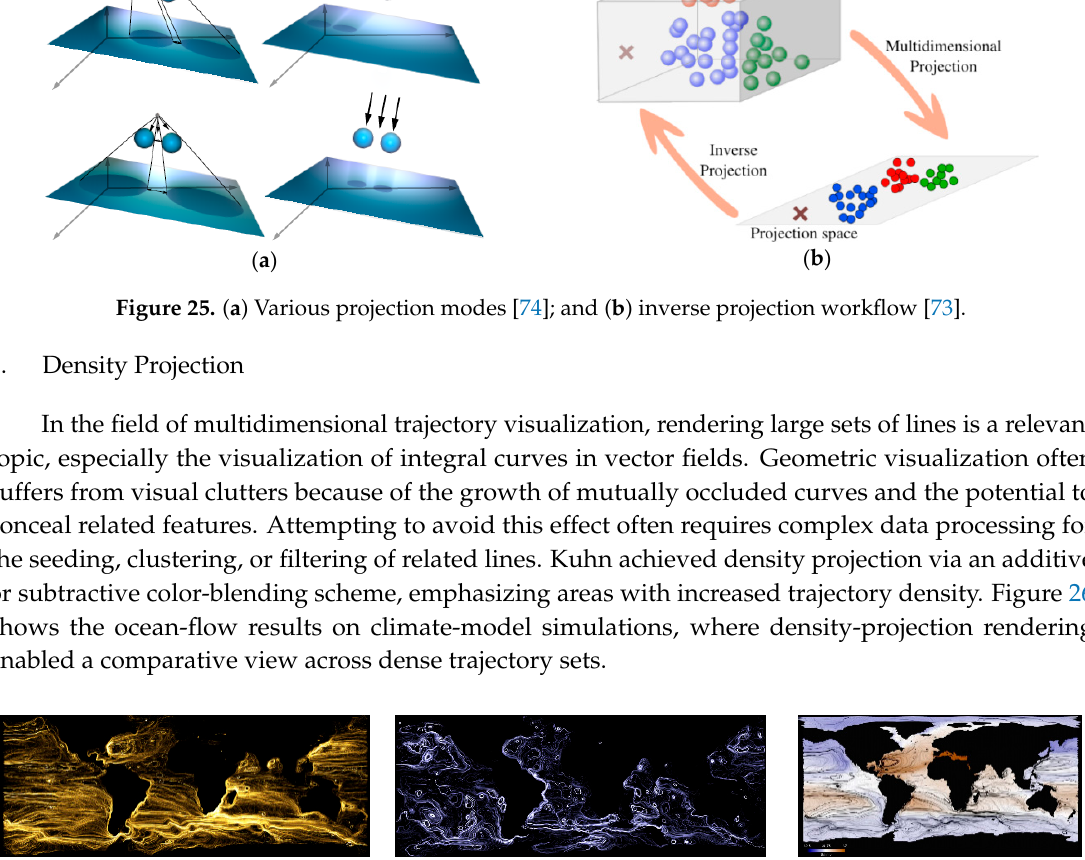
Figure 27. Dimensionality-reduction process that transforms the snapshot on the left into two- dimensional points on the right [76]. During the projection process, each snapshot must be converted into a high-dimensional vector. Figure 28 shows the weekday dynamic trajectory data recorded by real data. After preprocessing, the resulting dynamic graph network had a total of 180 vertices, 10.104 edges, and 2015 snapshots. Figures 28a,b shows the visualized views from a nonlinear projection method, with different periods encoded in different colors. Figure 28c shows the result of replacing the horizontal axis with a time axis in the PCA projection.